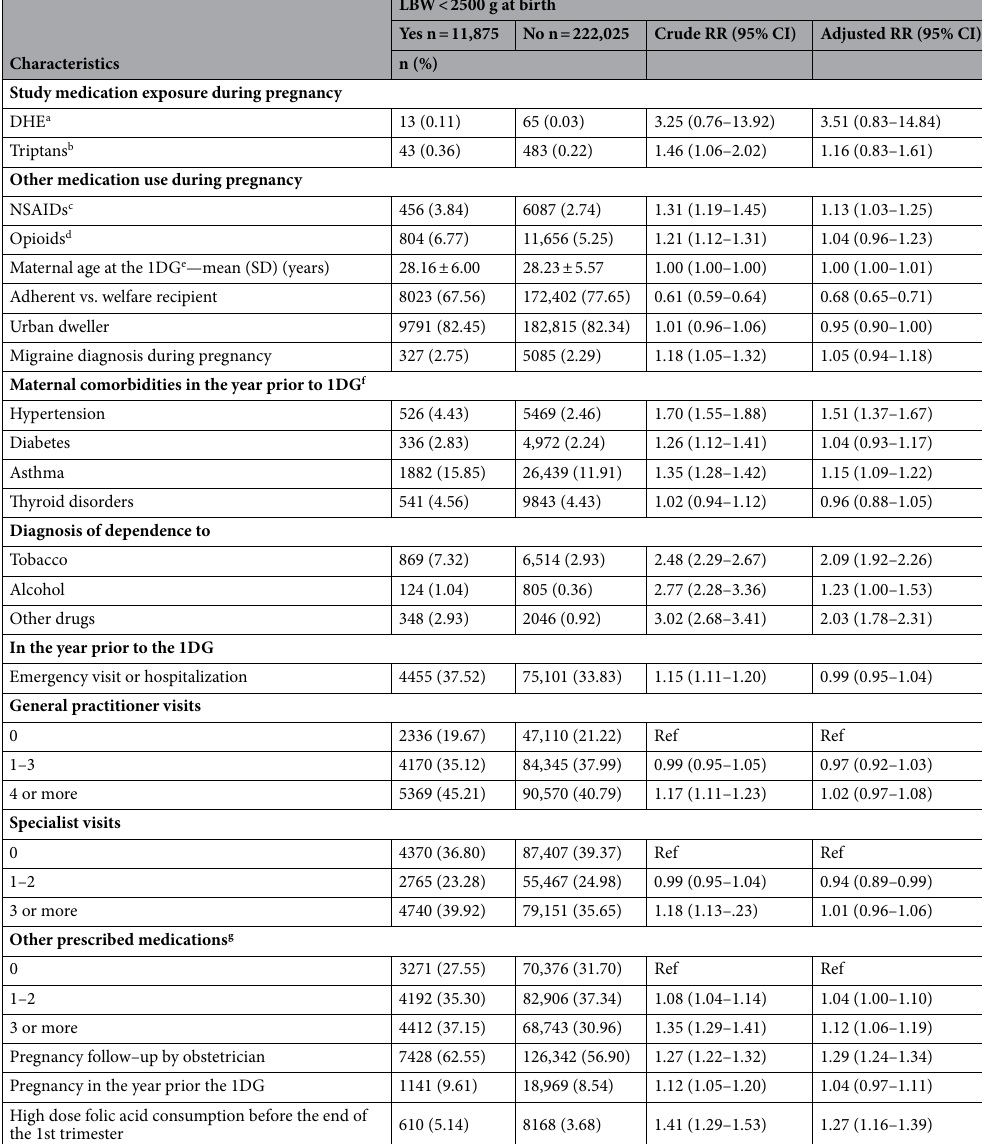
Table 3. Association between study medication exposure during pregnancy and the risk of LBW. a Dihydroergotamine; b Including almotriptan, eletriptan, naratriptan, rizatriptan, sumatriptan, and zolmitriptan; c Including celecoxib, diclofenac, diflunisal, etodolac, fenoprophen, fentanyl, flurbiprofene, hydrocodone, hydromorphone, ibuprofen, indomethacin, ketoprofen, mefenamic acid, meloxicam, nabumetone, naproxen, piroxicam, rofecoxib, sulindac, tiaprofenic acid, tolmetin, and valdecoxib; d Including codeine, meperidine, morphine, oxaprozin, oxycodone, oxymorphone, pentazocine, tapentadol, propoxyphen, and tramadol. Note: Pregnant women can use more than 1 study medication during pregnancy. e First day of gestation defined as the first day of the last menstrual period; f Comorbidities were assessed in the year prior